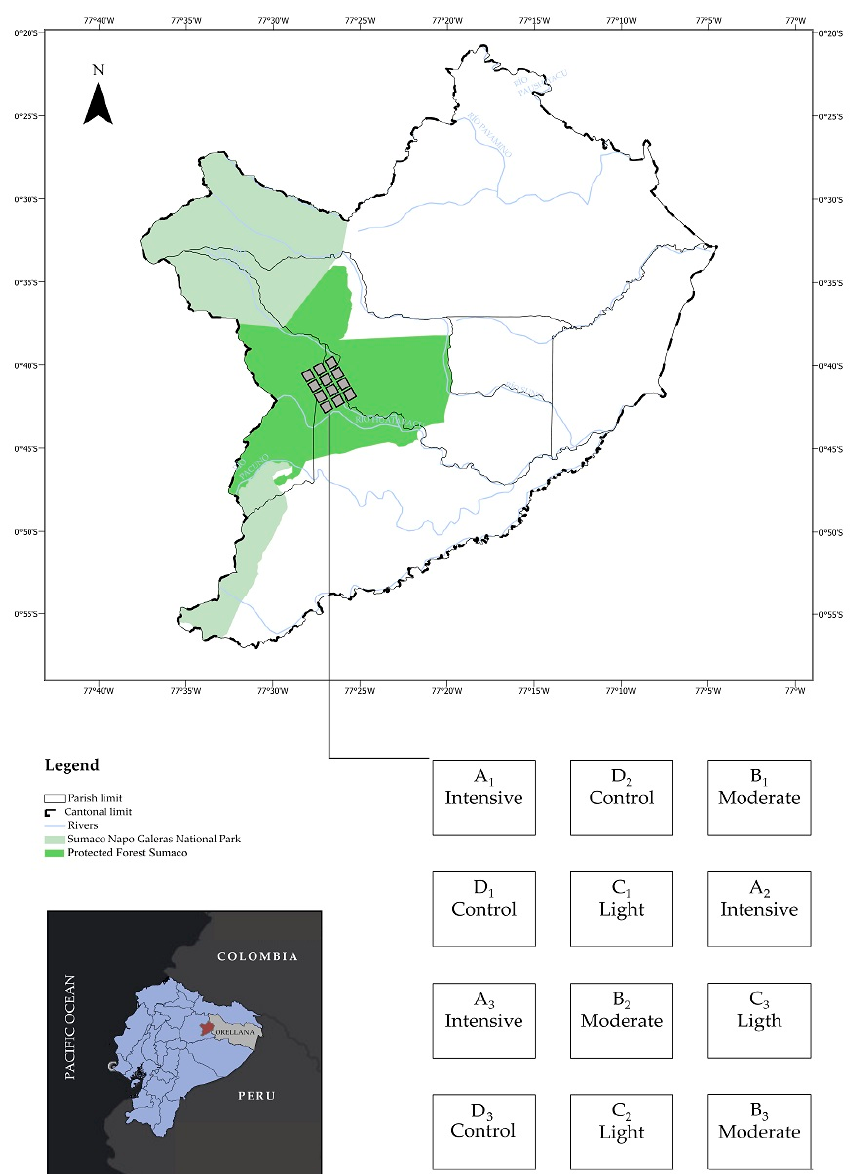
Figure 1. Location and design of the thinning trial for laurel, including areas with different manage- ment status in canton Loreto, Orellana Province.